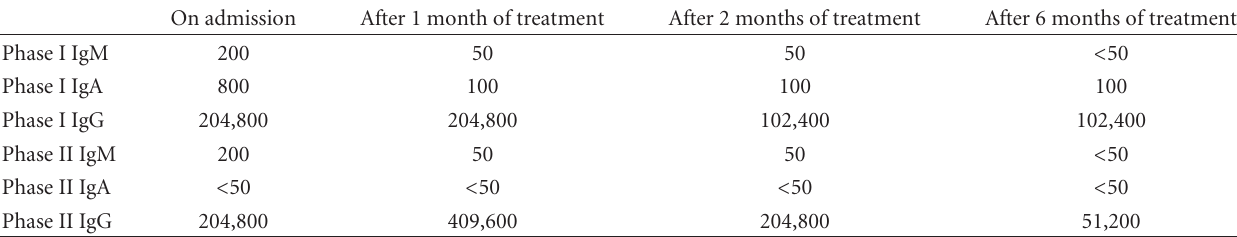
Table 2: C. burnetii titers